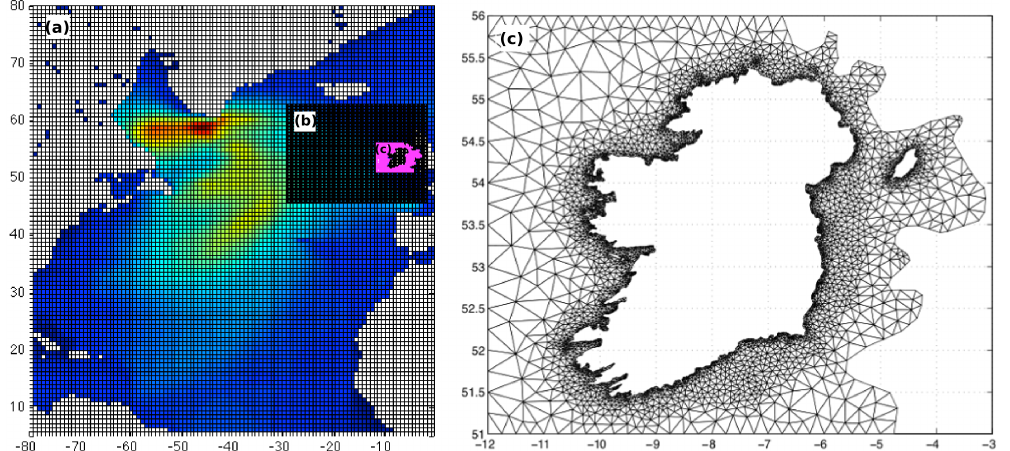
Figure 1. Left panel: the three wave model grids as described in Sect. 2.2. (a) The largest resolution North Atlantic grid has a 0.75 ◦ × 0.75 ◦ resolution. (b) The grid for the Northeast Atlantic has a 0.25 ◦ × 0.25 ◦ resolution. (c) The unstructured grid around Ireland has a resolution ranging from 15km offshore to 1km in the nearshore. Right panel: wave model unstructured grid used for the finest resolution domain around Ireland (c) . This grid has 4473 nodes and the resolution varies from 15km offshore to 1–2km in the nearshore.